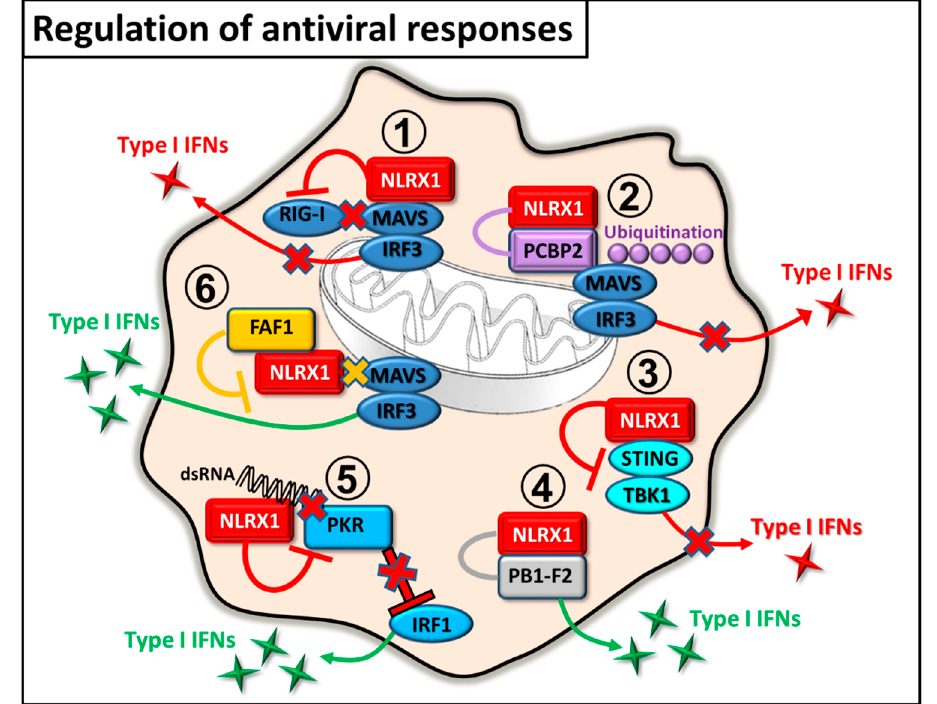
Figure 2. Regulation of antiviral responses by NLRX1. 1. NLRX1 inhibits RIG-I binding to MAVS, resulting in decreased type I IFN response. 2. NLRX1 recruits PCBP2 to MAVS and thereby triggers its ubiquitination and degradation that leads to reduced type I IFN levels. 3. NLRX1 prevents TBK1-mediated type I IFN secretion by binding to STING. 4. NLRX1 interacts with PB1-F2 and promotes type I IFN production. 5. NLRX1 competes with PKR for binding to double stranded RNA and prevents the PKR-driven blockade of host’s protein synthesis, which promotes the upregulation of IRF1-mediated early antiviral responses. 6. FAF1 interacts with NLRX1 and blocks the binding of NLRX1 to MAVS that positively effects the MAVS-mediated type IFN